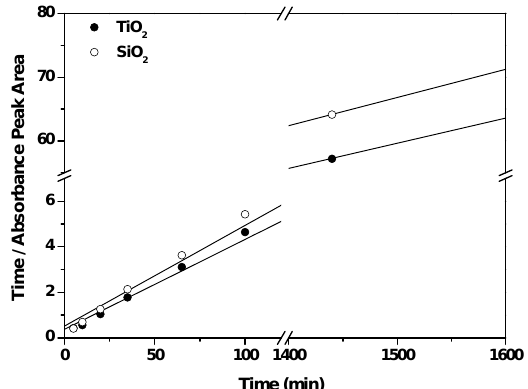
Figure 4. Linearized plot of the temporal evolution of the adsorption of RosB molecules infiltrated in MO 2 films. The corresponding fit is denoted with a continuous line while experimental data are labeled with